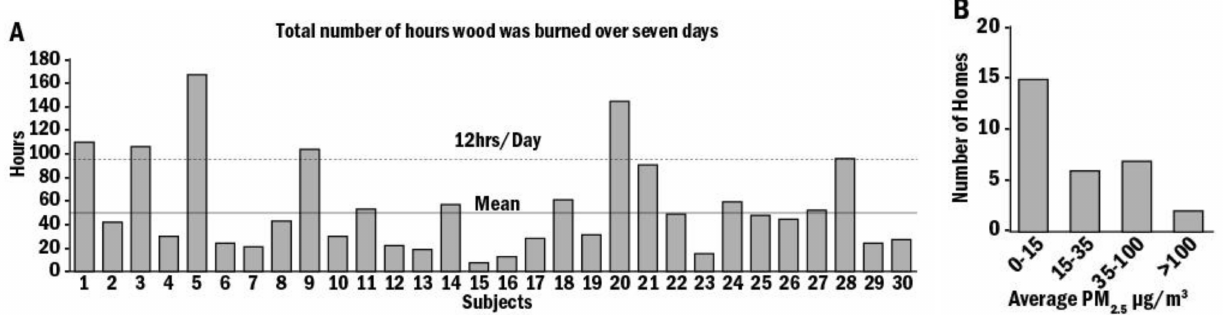
Figure 1. Total number of hours of wood burning in 30 homes. Total wood-burning time over the 7 days was calculated, and the mean wood-burning time over the test week was 50 ± 38 h with only one home burring 24 h a day ( A ). Average PM 2.5 frequency in different homes. Particulate mass was collected on filter, and total PM 2.5 emission was recorded over the test week from the 30 homes. Average PM 2.5 range was >100 µ g/m 3 in 1 home, 0–15 µ g/m3 in 15 homes, 15–35 µ g/m 3 in 6 homes, and 35–100 µ g/m 3 in 8 homes ( B